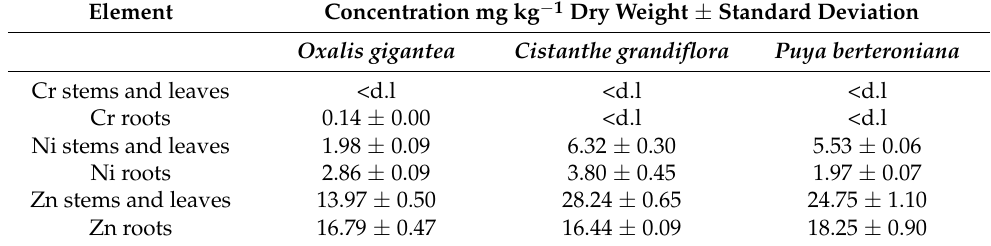
Table 4. The initial concentrations of Cr, Ni, and Zn in plants ± standard deviation.